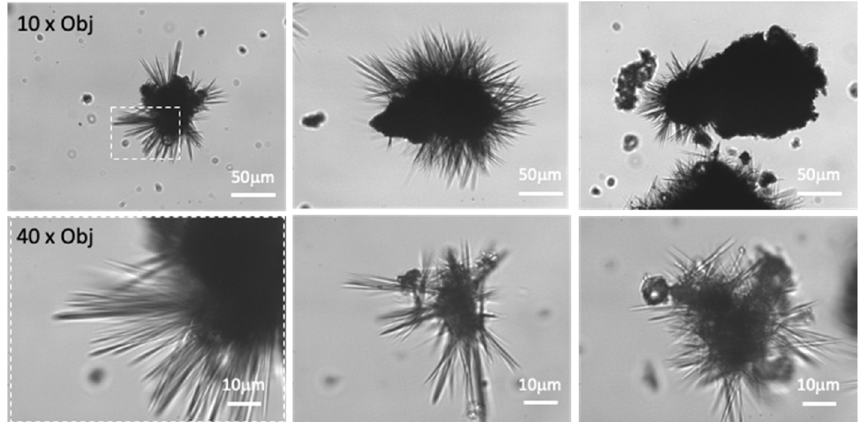
Fig. 18 Optical microscope images of particles from the stirred sample undergoing dissolution and morphologic change at 25–30 min after addition in pH 9.33 TBSS. (Top) images with the 10 first (top) image, the white dotted region-of-interest at 10